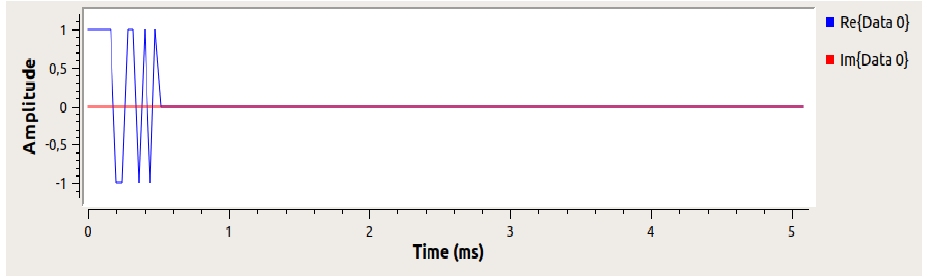
Fig. 3. Subcarrier of the transmitted OFDM signal with BPSK .